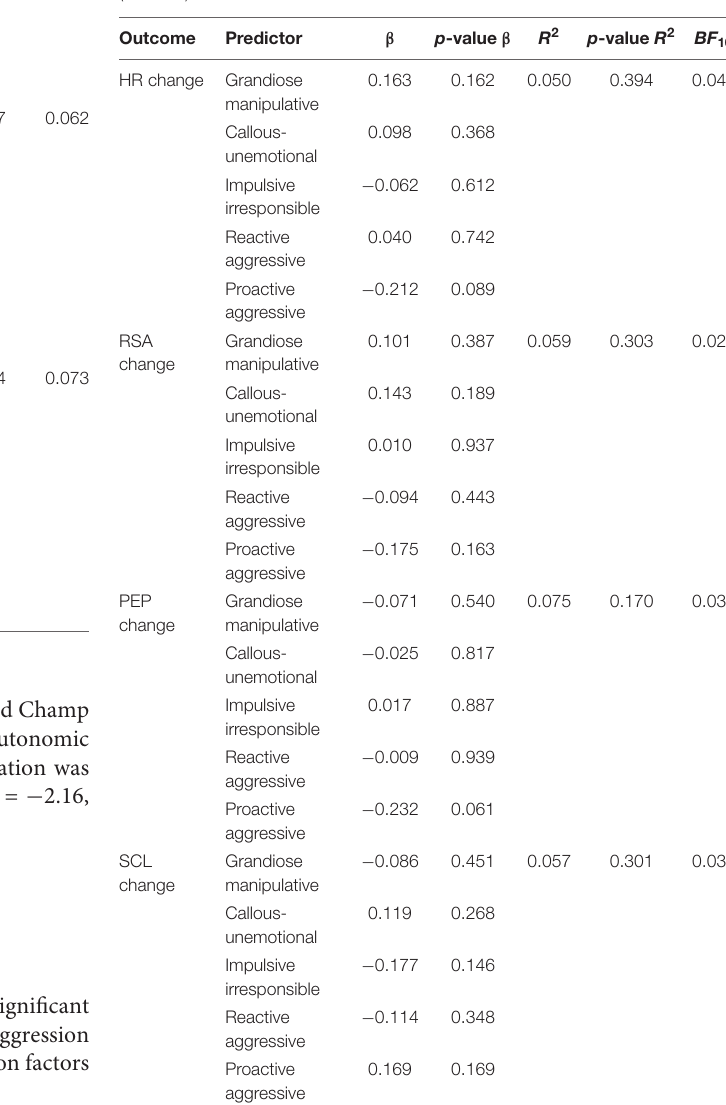
TABLE 4 | ANS reactivity regression models within multi-problem young adults ( N =